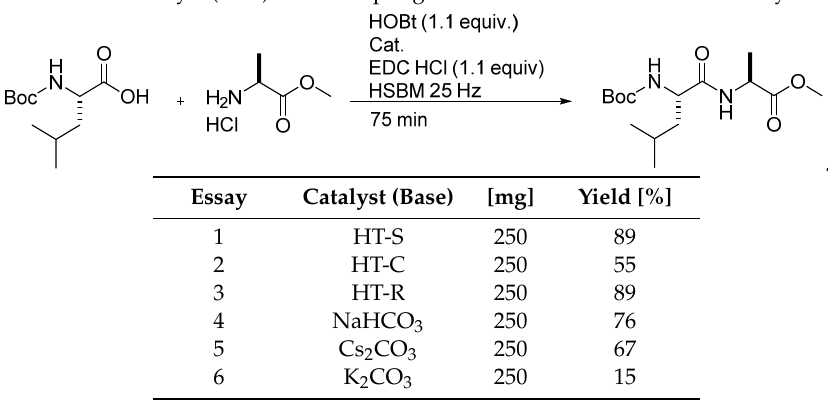
Table 1. Effect of the catalyst (base) in the coupling reaction of amino acids activated by HSBM [75].